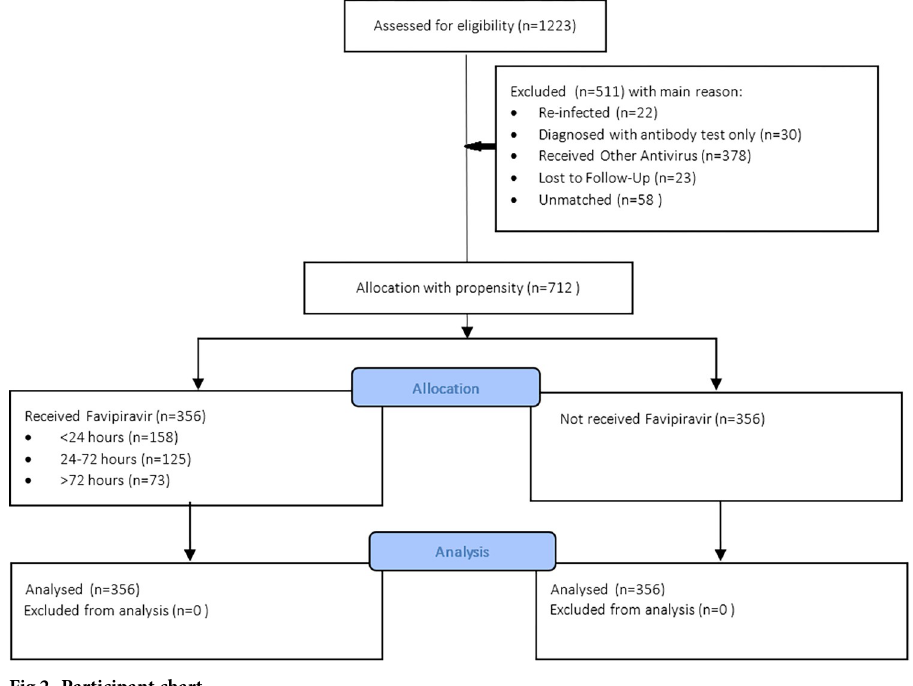
Fig 2. Participant